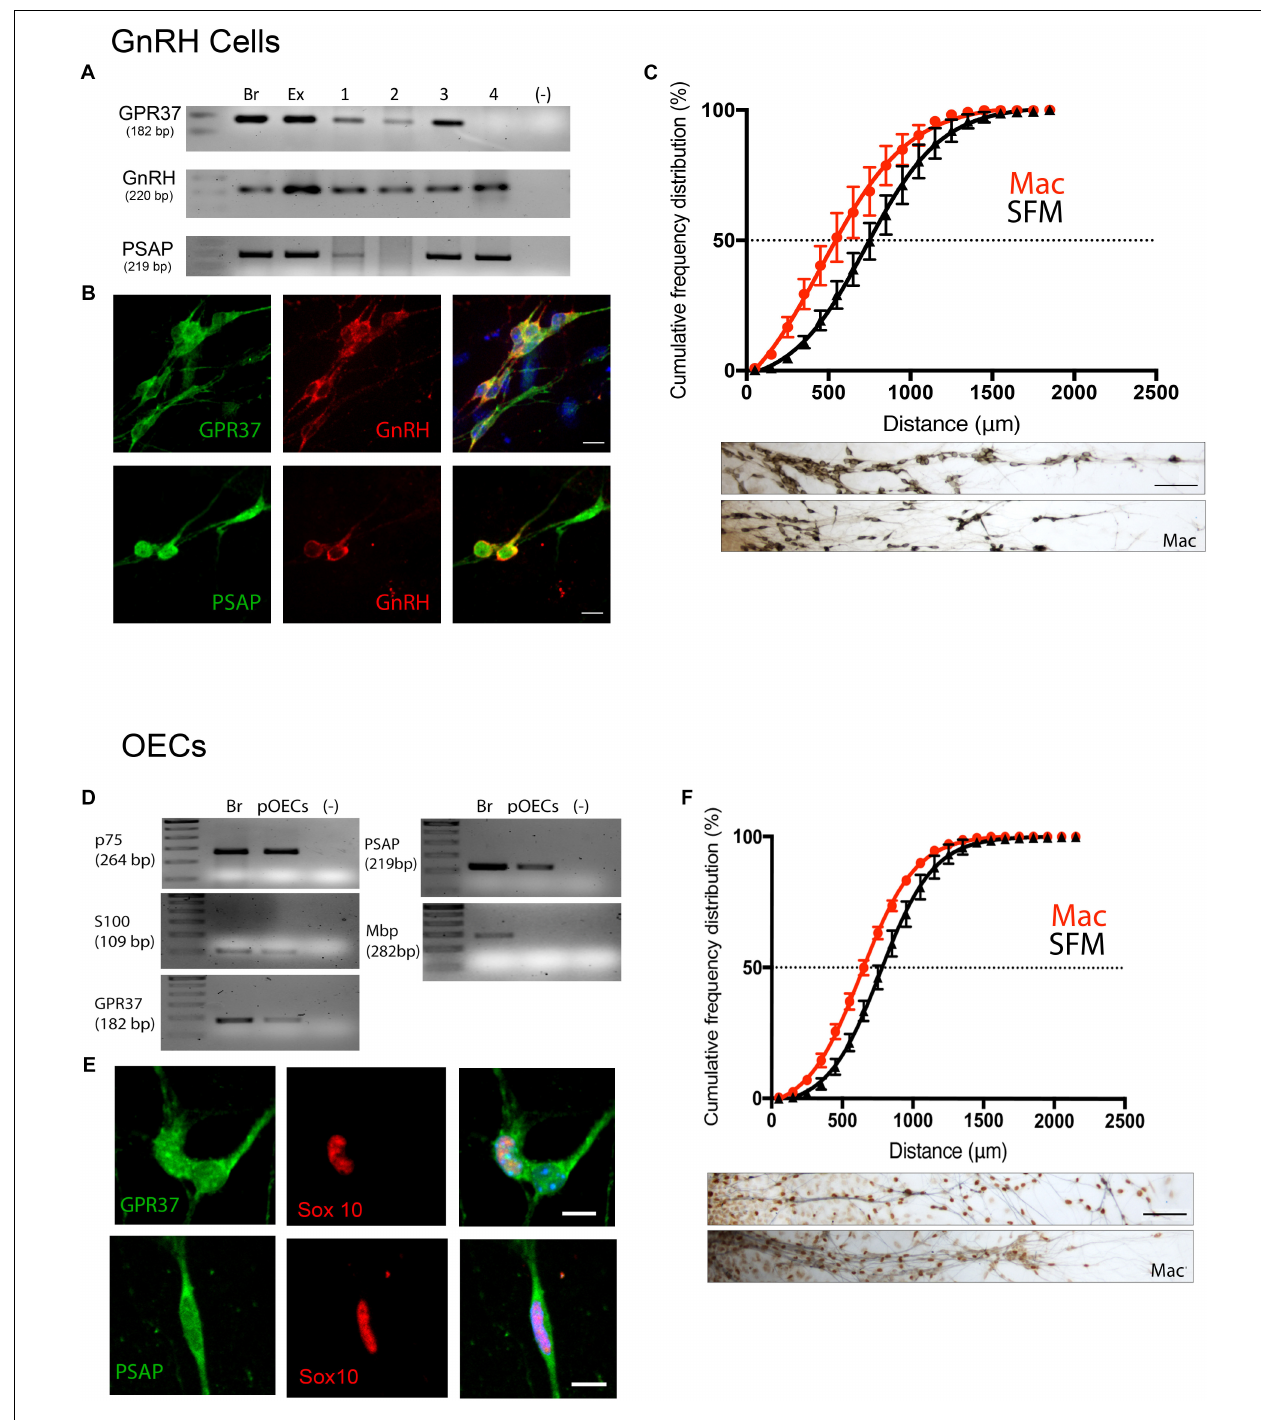
FIGURE 5 | Inhibition of GPR37 in nasal explants attenuates migration of GnRH cells and OECs. (A–C) Analysis of GnRH cells. (D,E) Analysis of OECs. GPR37 and PSAP are expressed in migrating GnRH neurons and OECs as determined by PCR (A,D) and immunofluorescent staining on 4DIV explants (B,E) . Chronic application of Macitentan (Mac, a GPR37 antagonist) decreases migration of GnRH cells (C) and OECs (F) . Migration data presented as the cumulative frequency of Mac treated groups (red) vs. SFM groups (black), and indicate that Mac treatment reduced (shifted to the left) the distance both GnRH cells and OECs moved. Panels below each histogram show examples of stained GnRH/OECs (GnRH and Sox10, brown) and olfactory sensory fibers (pheripherin, blue). Statistics for measurements: GnRHs, N = 6 explants per group. For OECs, N = 11 and N = 14 explants for control and treatment groups. Scale bar: (B,D) = 10 µ m, (C,F) = 50 µ